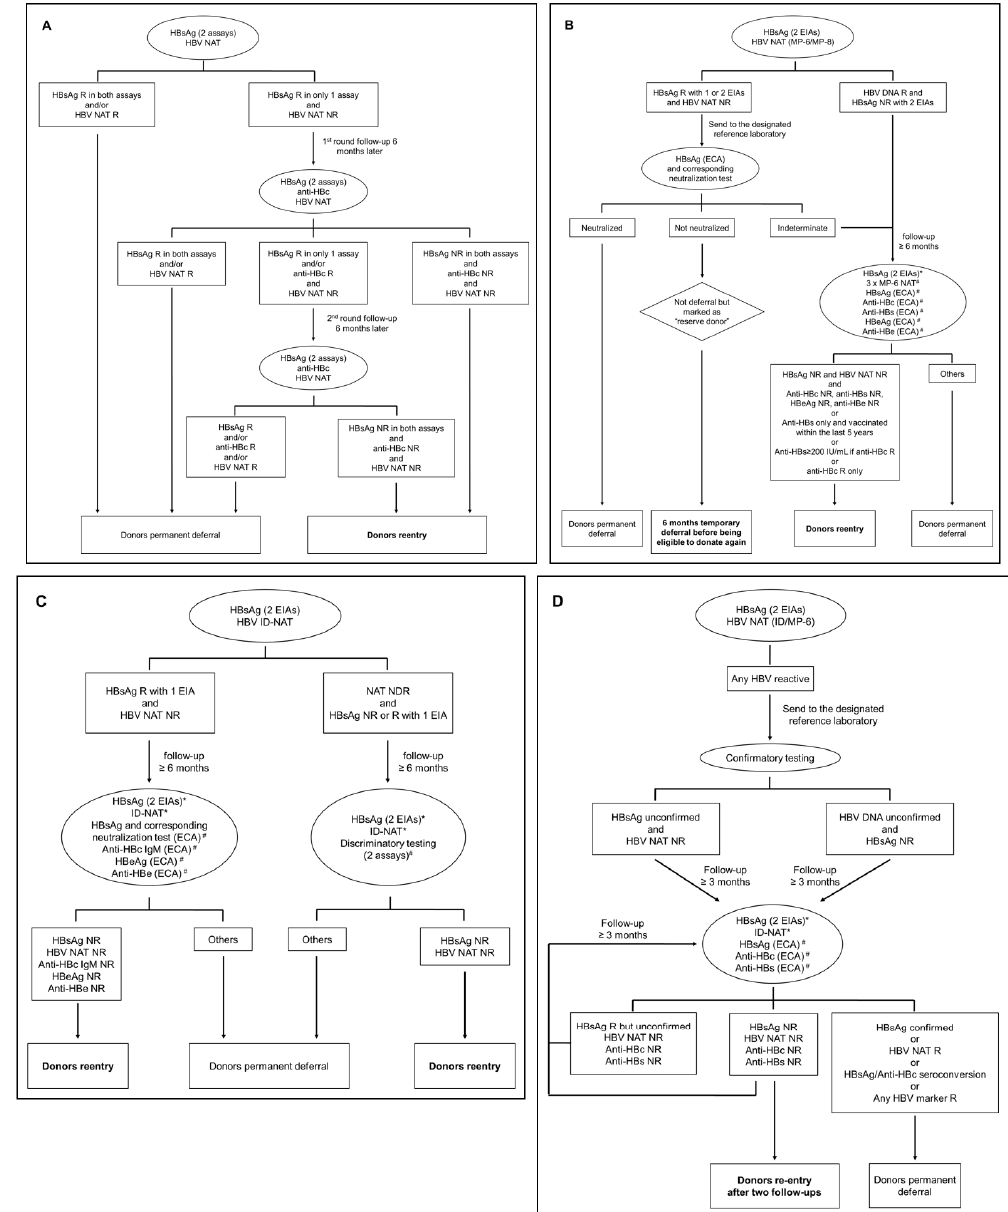
Figure 2. Guidelines for re-entry of donors reactive in a single HBsAg assay and/or NAT nonreac- tive: CSBT Guidelines ( A ), Jiangsu Guidelines ( B ), Zhejiang Guidelines ( C ), and Dalian